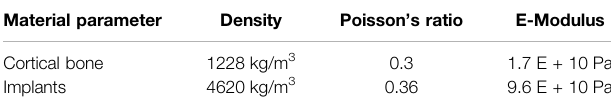
TABLE 1 | The material parameters in the three-dimensional (3D) fi nite element analysis. Material